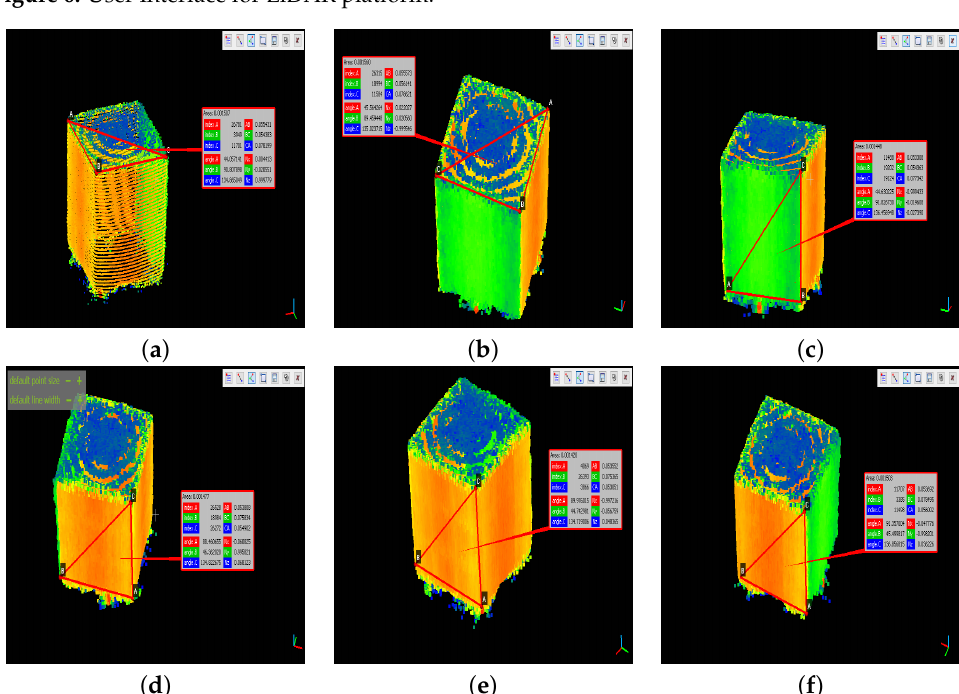
Figure 7. Measurement of the cube edges. ( a ) U1 and U2. ( b ) U3 and U4. ( c ) L1 and D1. ( d ) L2 and D2. ( e ) L3 and D3. ( f ) L4 and